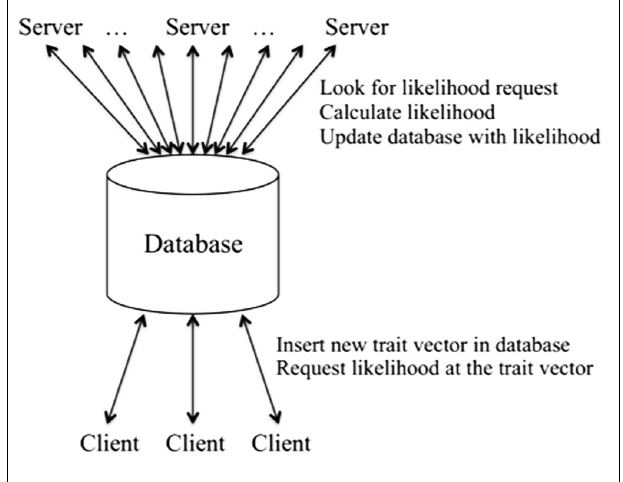
FIGURE 1 | Client–server architecture in